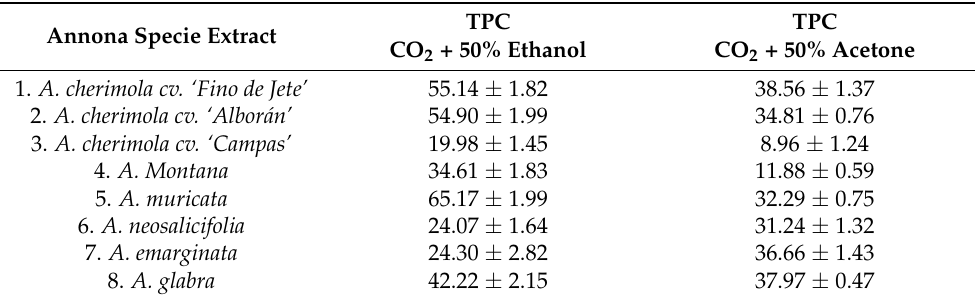
Table 1. Total phenolic content (TPC) of leaf extracts obtained from different species of Annona by using CO 2 /ethanol and CO 2 /acetone in terms of µ g AG/ µ g dried extract.